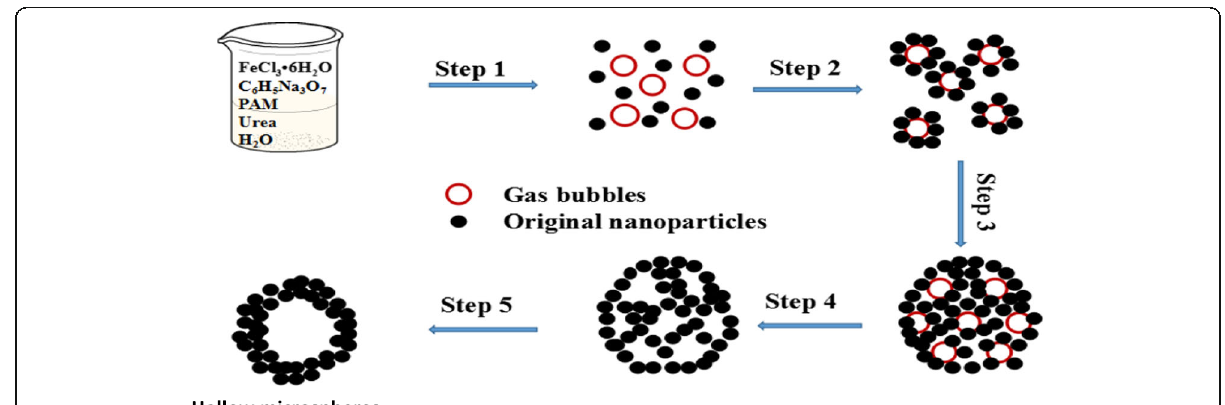
Fig. 10 Schematic illustration of the formation mechanism of Fe 3 O 4 hollow